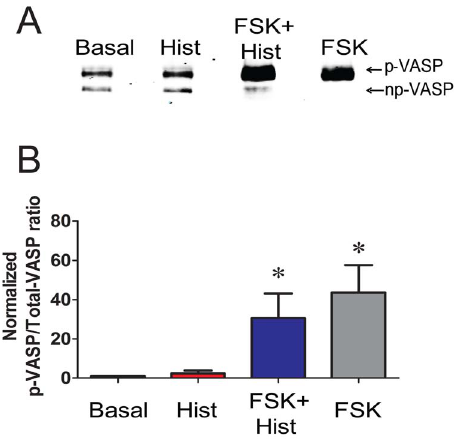
Figure 6. Preincubation with forskolin reduces phosphoryla- tion of cofilin in PCA. PCA rings were treated with the same conditions as described in Figure 3. Proteins were extracted and separated on SDS polyacrylamide gels and p-cofilin was detected by western blotting. Panel A: Representative western blot of p-cofilin and np-cofilin. Panel B: Cumulative data representing the relative amounts of p-cofilin over the total cofilin and then normalized to the basal. Quantitative values were obtained when the phosphorylated and non- phosphorylated bands were quantitated densitometrically. n=4, p , 0.05. *significant compared to all other conditions.